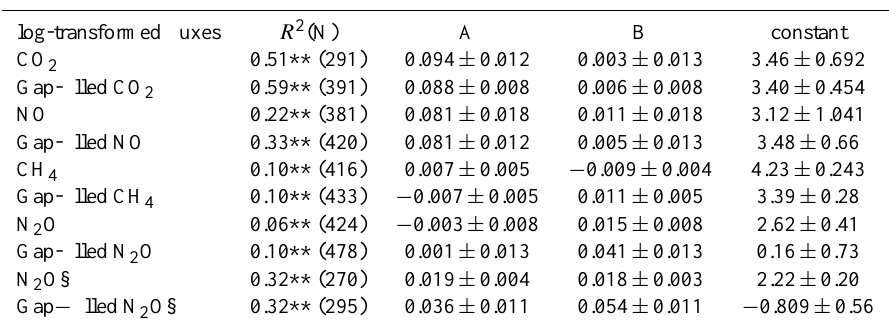
Table 5. Results from linear regression analysis of log-transformed soil N 2 O [ µ gNm − 2 h − 1 ], NO [ µ gNm − 2 h − 1 ], CO 2 [mgCm − 2 h − 1 ] and CH 4 [ µ gCm − 2 h − 1 ] fluxes on weekly scales. For this regression analysis soil temperature in 5cm depth [ ◦ C] and soil moisture [WFPS in%] in 10cm depth were used as describing